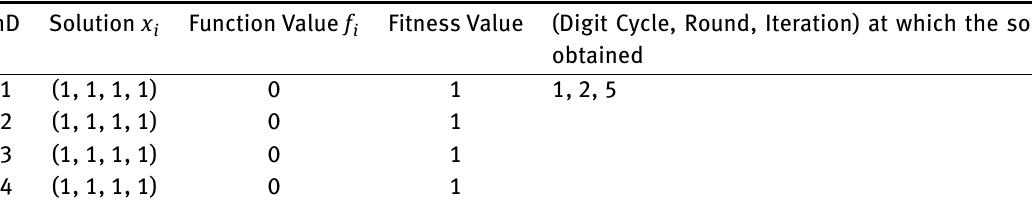
Table 16: Digit Cycle Results for Rosenbrock’s function with 4 variables